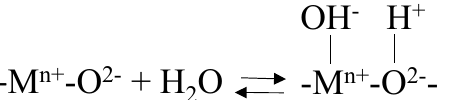
Figure 5. Interaction between a water molecule and the surface coordinatively unsaturated metal cations and oxygen